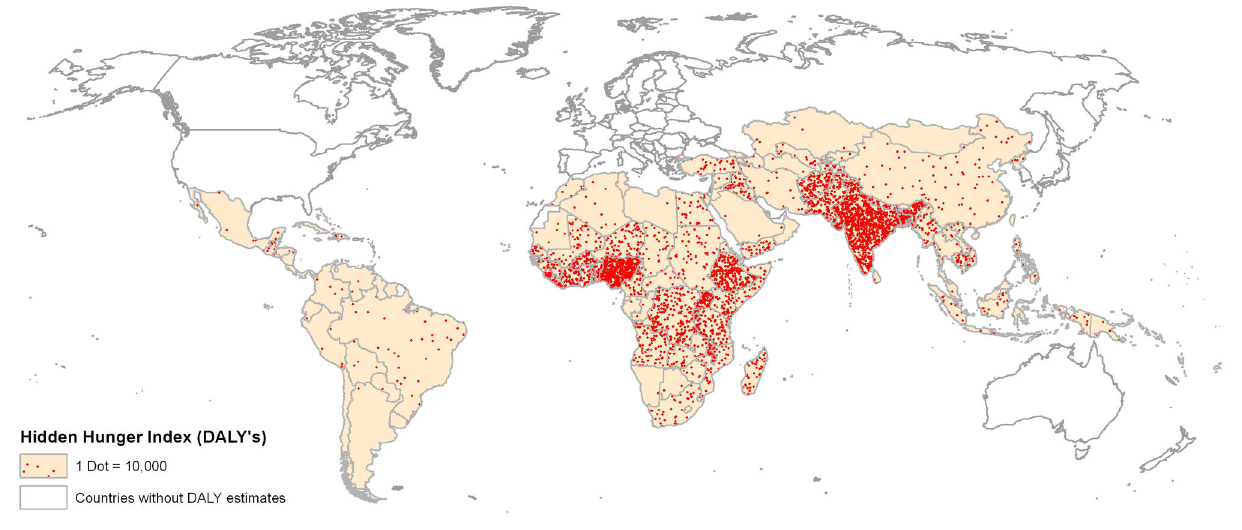
Figure 7. Total population-unadjusted Disability Adjusted Life Years (DALYs) attributed to micronutrient deficiencies in 136 countries. This includes iron, vitamin A, and zinc micronutrient deficiencies. doi: